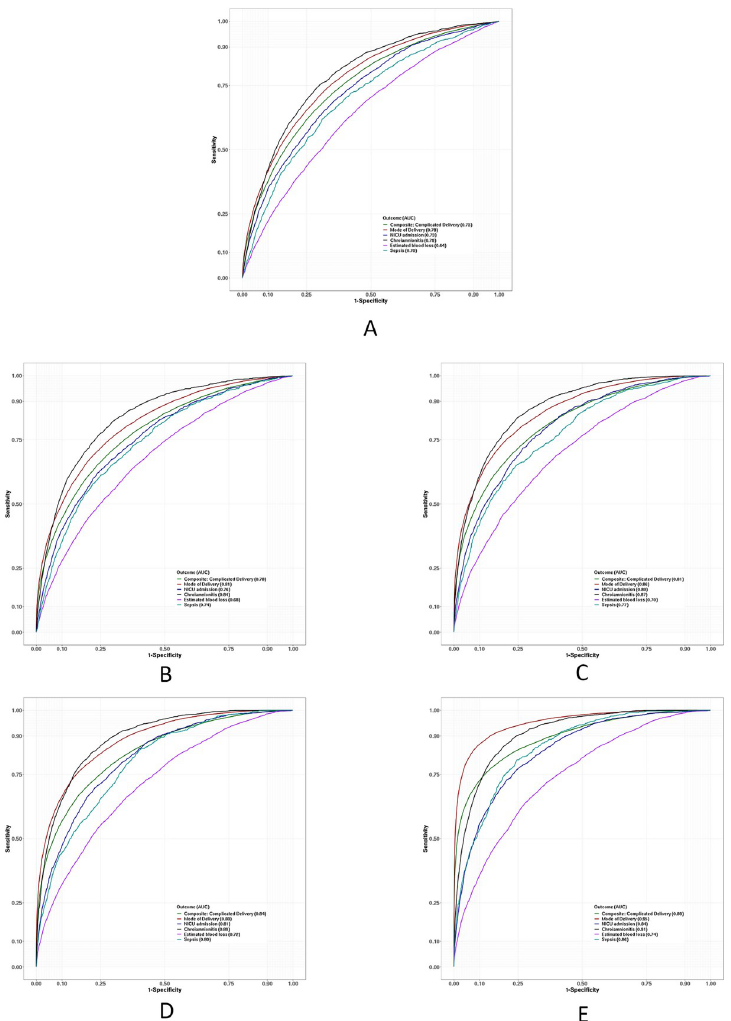
Fig 2. Diagnostic performance of baseline and intrapartum prediction models for composite unfavorable labor outcome. A, Area under curve (AUC) on admission. B, AUC at 4 cm cervical dilation. C, AUC at 6 cm cervical dilation. D, AUC at 8 cm cervical dilation. E, AUC at 10 cm cervical dilation. NICU indicates neonatal intensive care